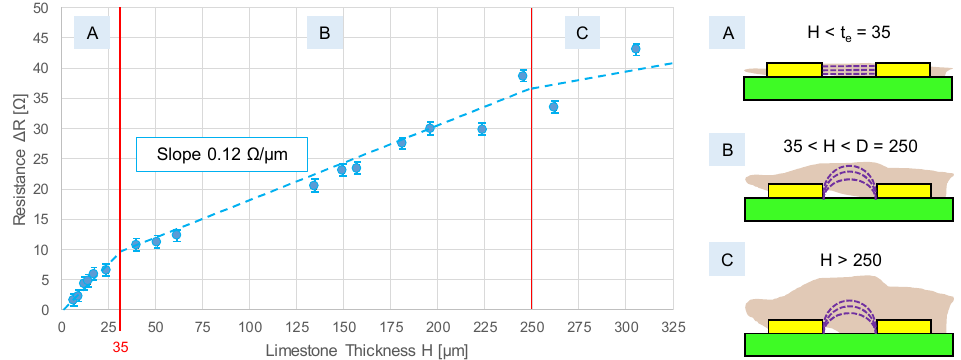
Figure 7. The response curve of the slime monitor for increasing thickness H of limestone, showing three regions of sensitivity.